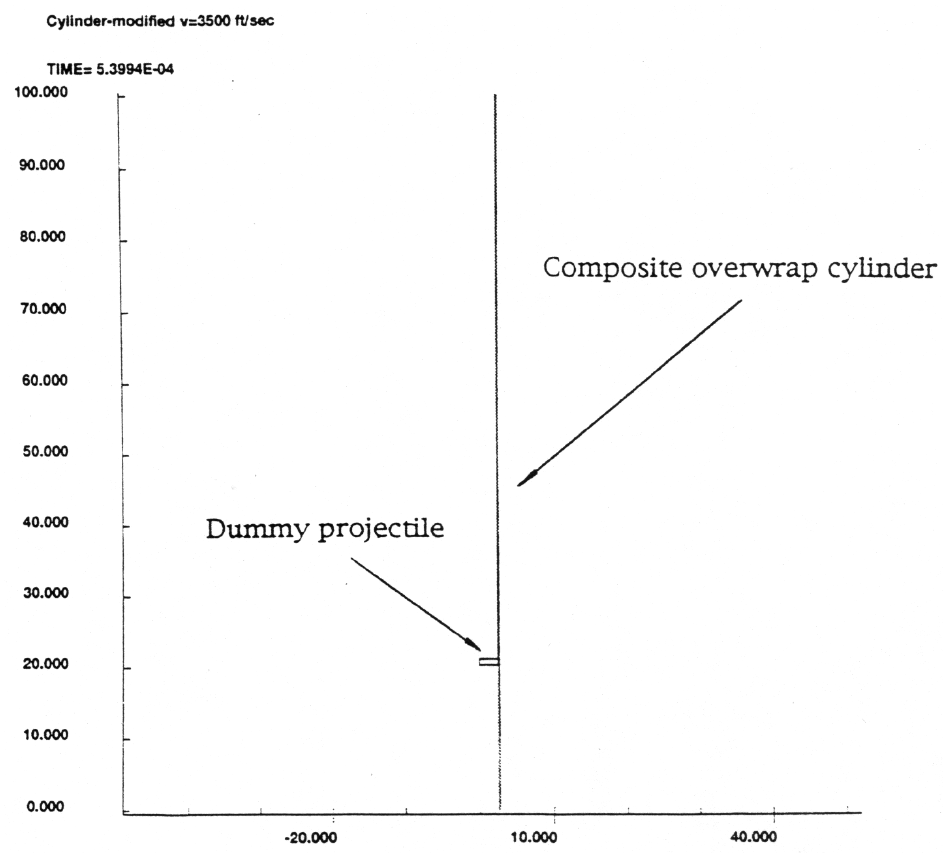
Fig. 3. FEM model of a projectile moving along a gun